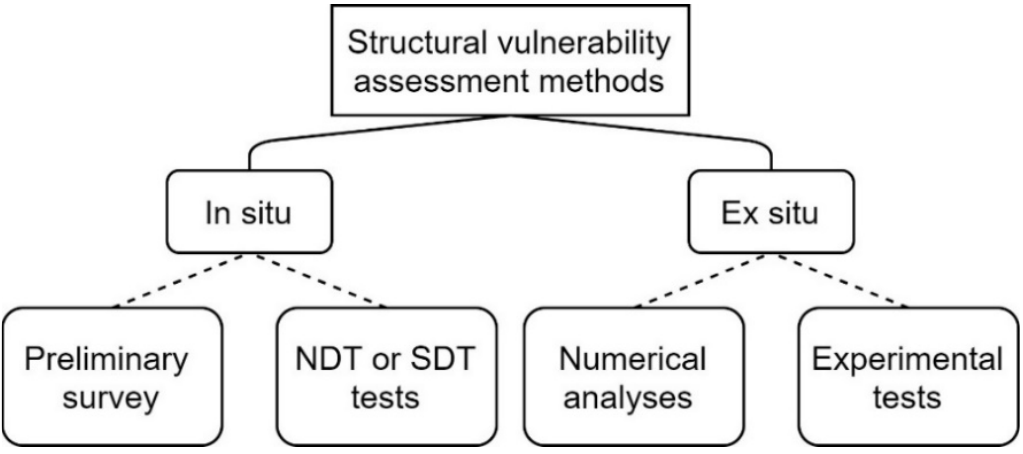
Figure 4. Classification of methods for vulnerability assessments of heritage timber buildings.